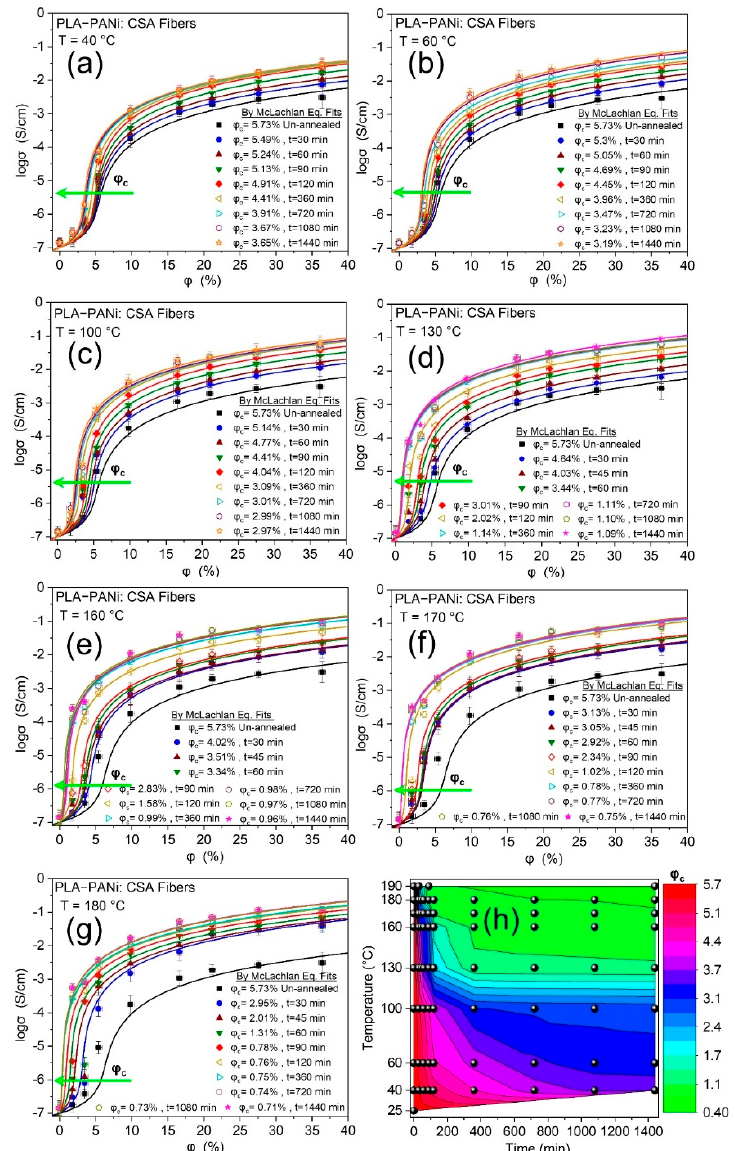
Figure 3. Logarithm of conductivity ( log σ ) against percentage volume fraction ( ϕ % ) of PANi for PLA-PANi:CSA fibers. ( a – g ) show the time-temperature dependence on percolation threshold ϕ c . The solid lines show the closest fits with the GEM model (Equation (1b)). ( h ) shows the contour plot representation between time, temperature, and ϕ c